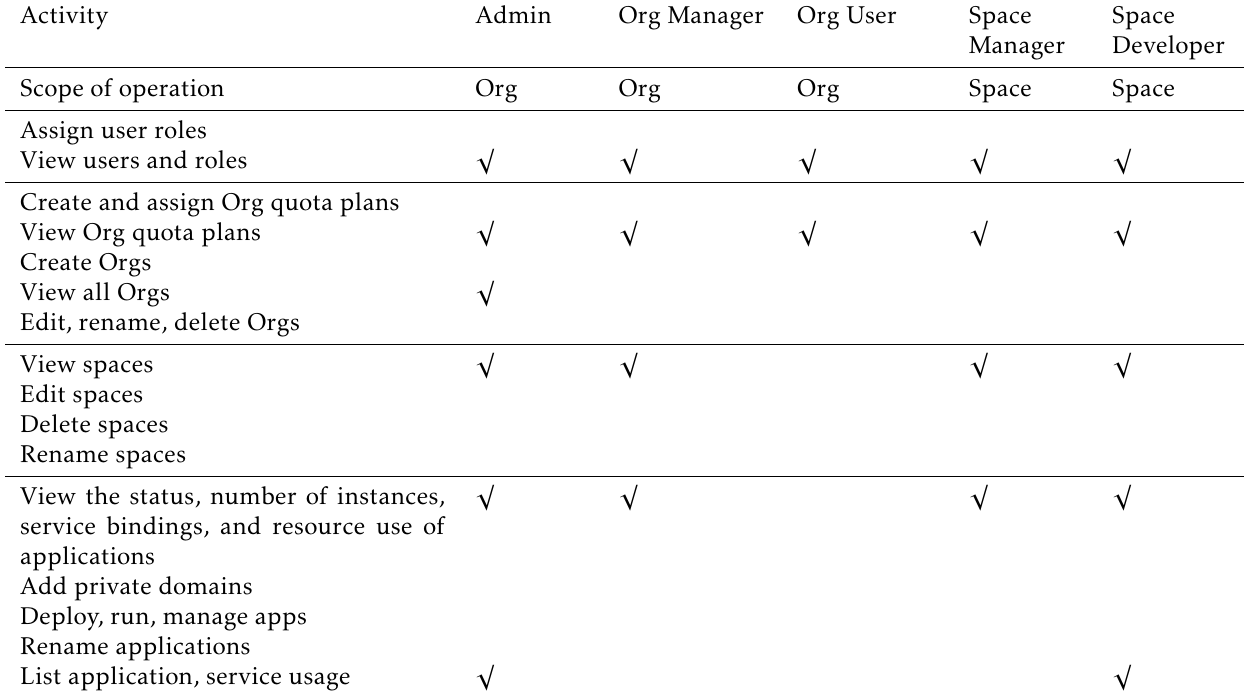
Table 2. Location-aware RBAC for Active Orgs when the location is public . "